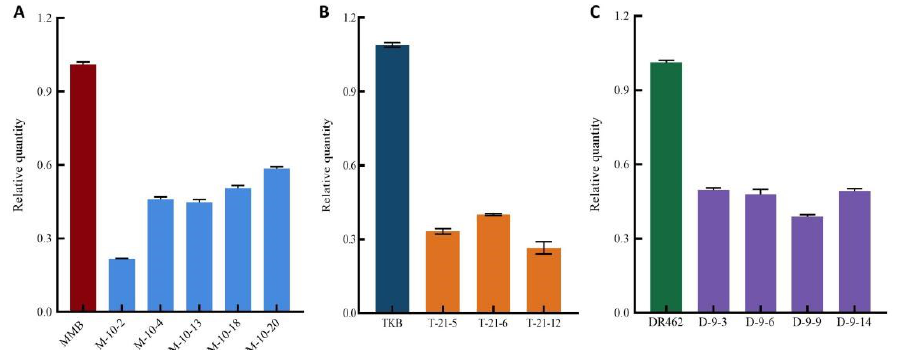
Figure 6. Relative expression level of Wx gene in mutant lines in T 2 generation and their respective wild type. ( A ): MMB; ( B ): TKB; ( C ): DR462; In the mutant lines, M, T, and R are short for MMB, TKB,